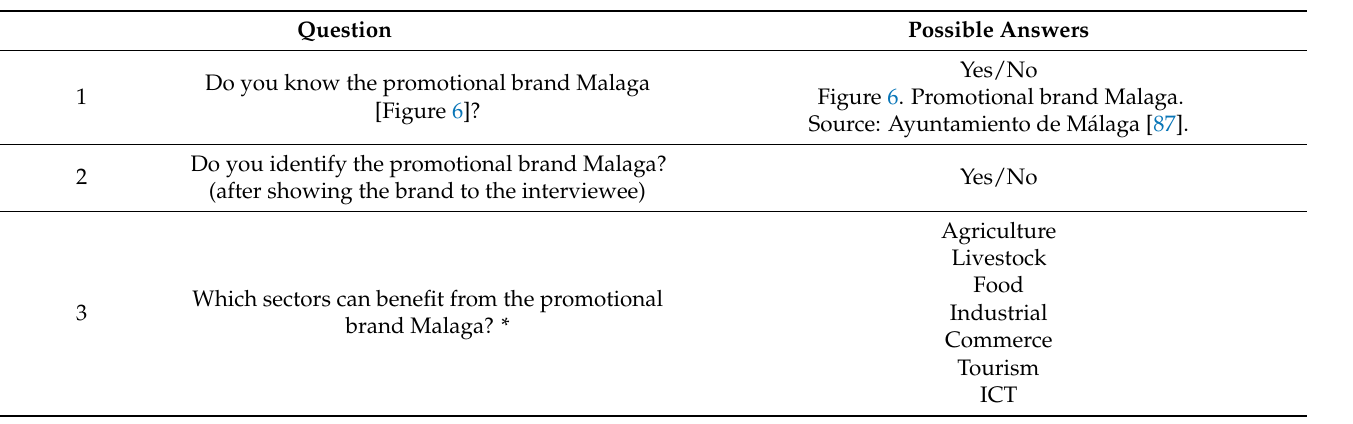
Figure 6. Promotional brand